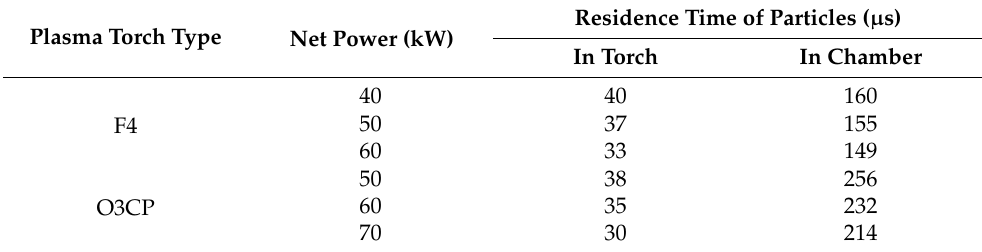
Table 2. Residence time of particles in the plasma torch and deposition chamber under different arc net